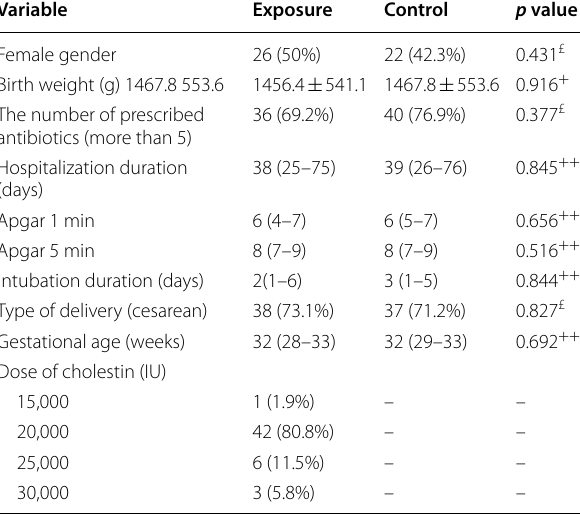
Table 1 The characteristics of the neonates in the two groups